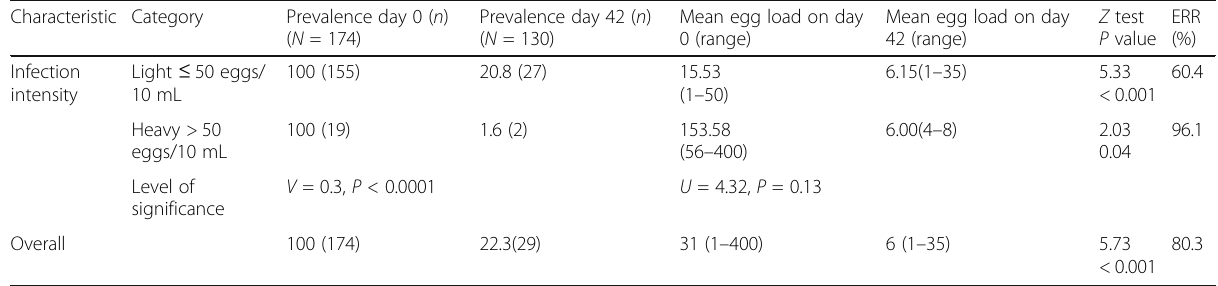
Table 4 Efficacy of praziquantel against S. haematobium on day 42 post-treatment with respect to initial infection intensity in the Ikata-Likoko area of southwest Cameroon